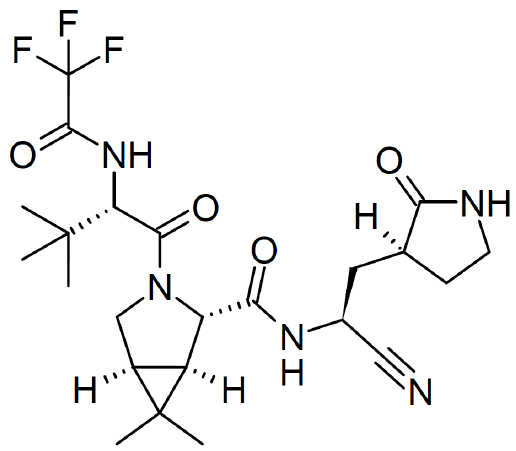
Figure 2. Structure of nirmatrelvir.